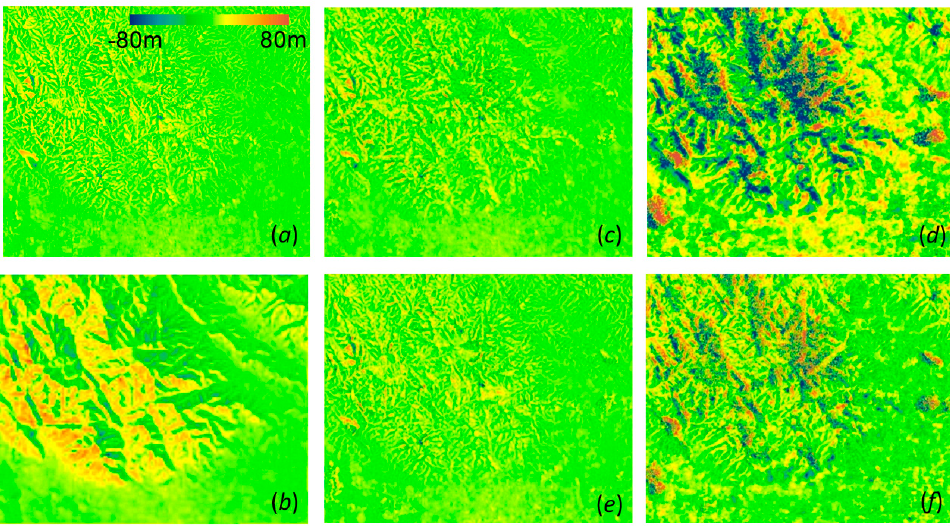
Figure 11. The height error map of InSAR DEMs, ( a ) the DEM generated by ML estimation with prior DEM; ( b ) SRTM DEM; ( c – f ) are the DEMs generated by single-baseline interferograms I, II, III, and IV. Table 7. Statistical values of height errors of single/multi-baseline InSAR DEMs and SRTM DEM. Mean Std.